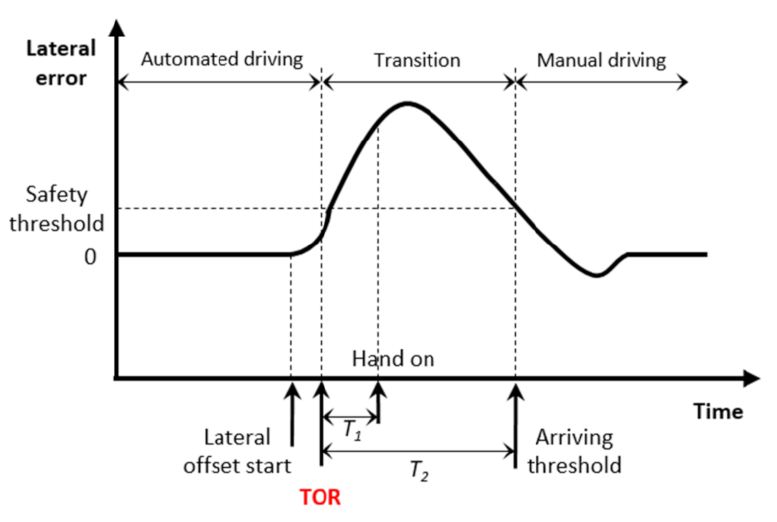
Figure 3. Concept of the take-over